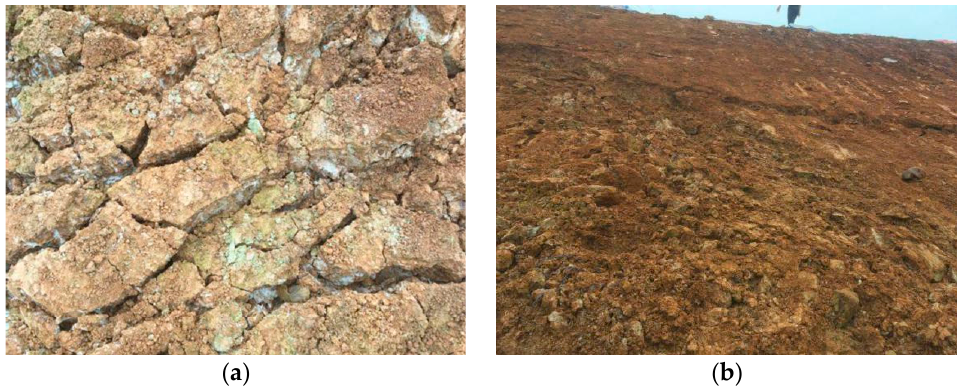
Figure 2. Disintegration damage under the action of wet and dry cycles: ( a ) disintegration damage; and ( b ) severe soil damage.